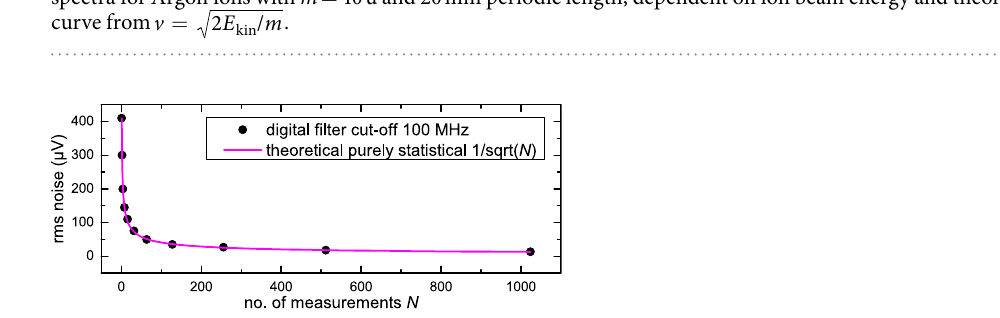
Figure 6. Rms noise voltage of ICD2 averaged over N acquisitions, excluding the interference from switching the beam blanker. The theoretical N 1/ -dependence expected for uncorrelated statistical noise is shown for